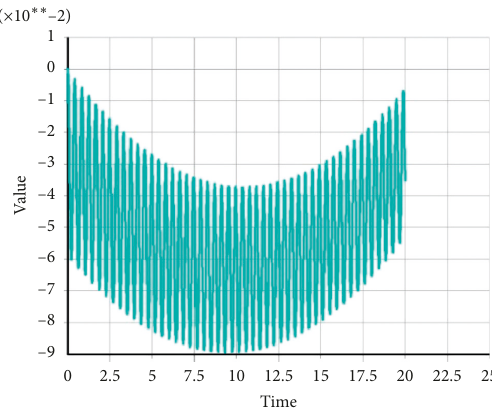
Figure 9: Time-varying deformation curve of springs. Figure 7: Mises equivalent stress curve of point A.